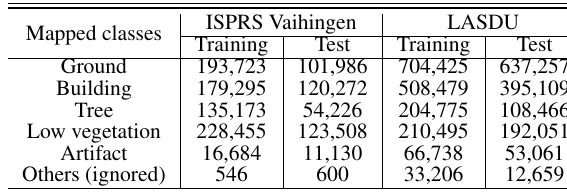
Table 2. Point distributions in ISPRS Vaihingen and LASDU